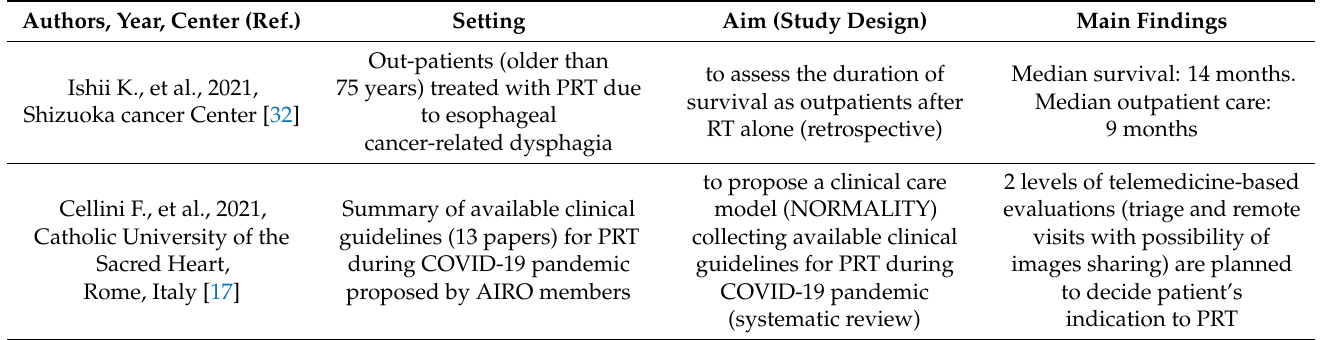
Table 3. Characteristics and main findings on studies on improved home care and outpatient status by palliative